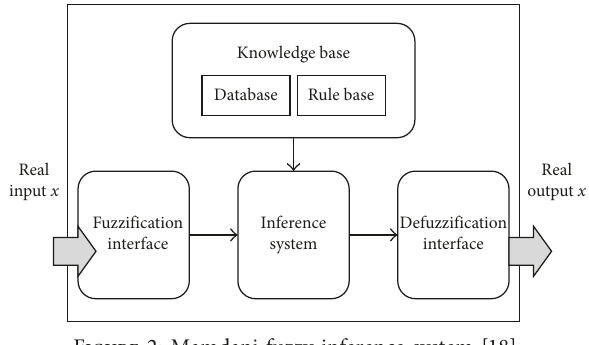
Figure 2: Mamdani fuzzy inference system